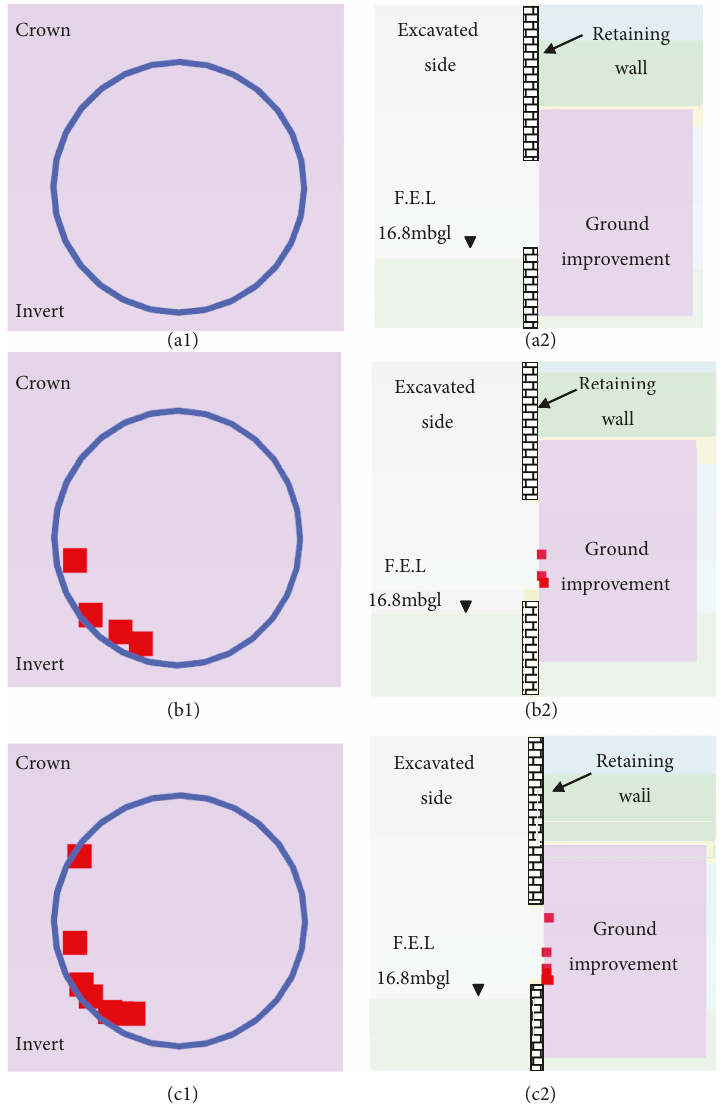
Figure 16: Impacts from various soil sti ff ness (elastic modulus) on failure caused by launching of a shield for (a) 65 × 10 3 kPa, (b) 130 × 10 3 kPa, and (c) 260 × 10 3 kPa. Note: “ 1 ” means transverse direction and “ 2 ” means longitudinal